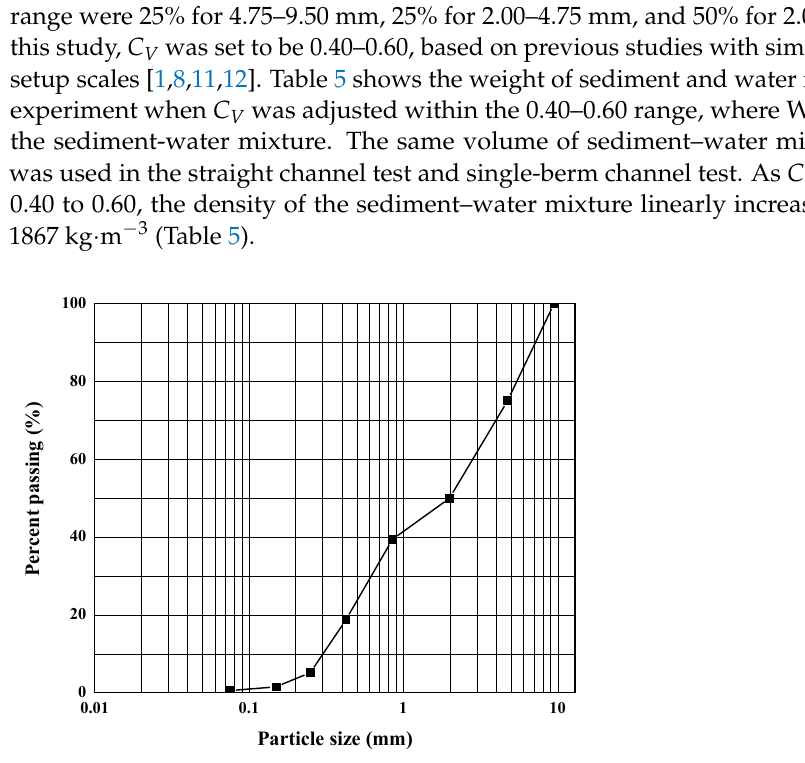
Figure 3. Grain-size distribution curve of the mixed sediment used in the debris flow.